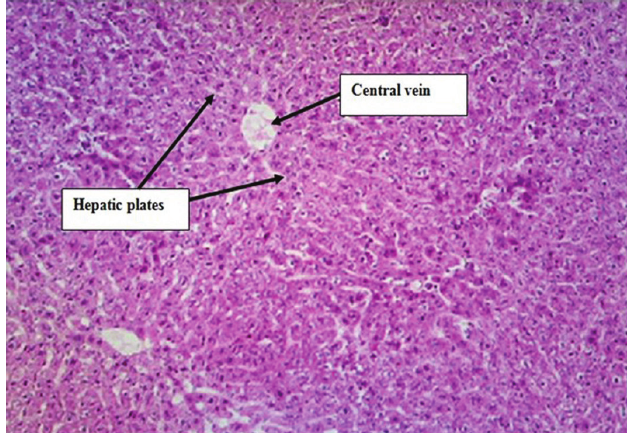
FIGURE 13 - Effect of risperidone on the liver of rats (H & E, 100x, 3 µ): Representative images of liver of rats treated with risperidone (2.5 mg/kg/d orally for three weeks showing no hepatic architectural changes as compared to normal saline treated